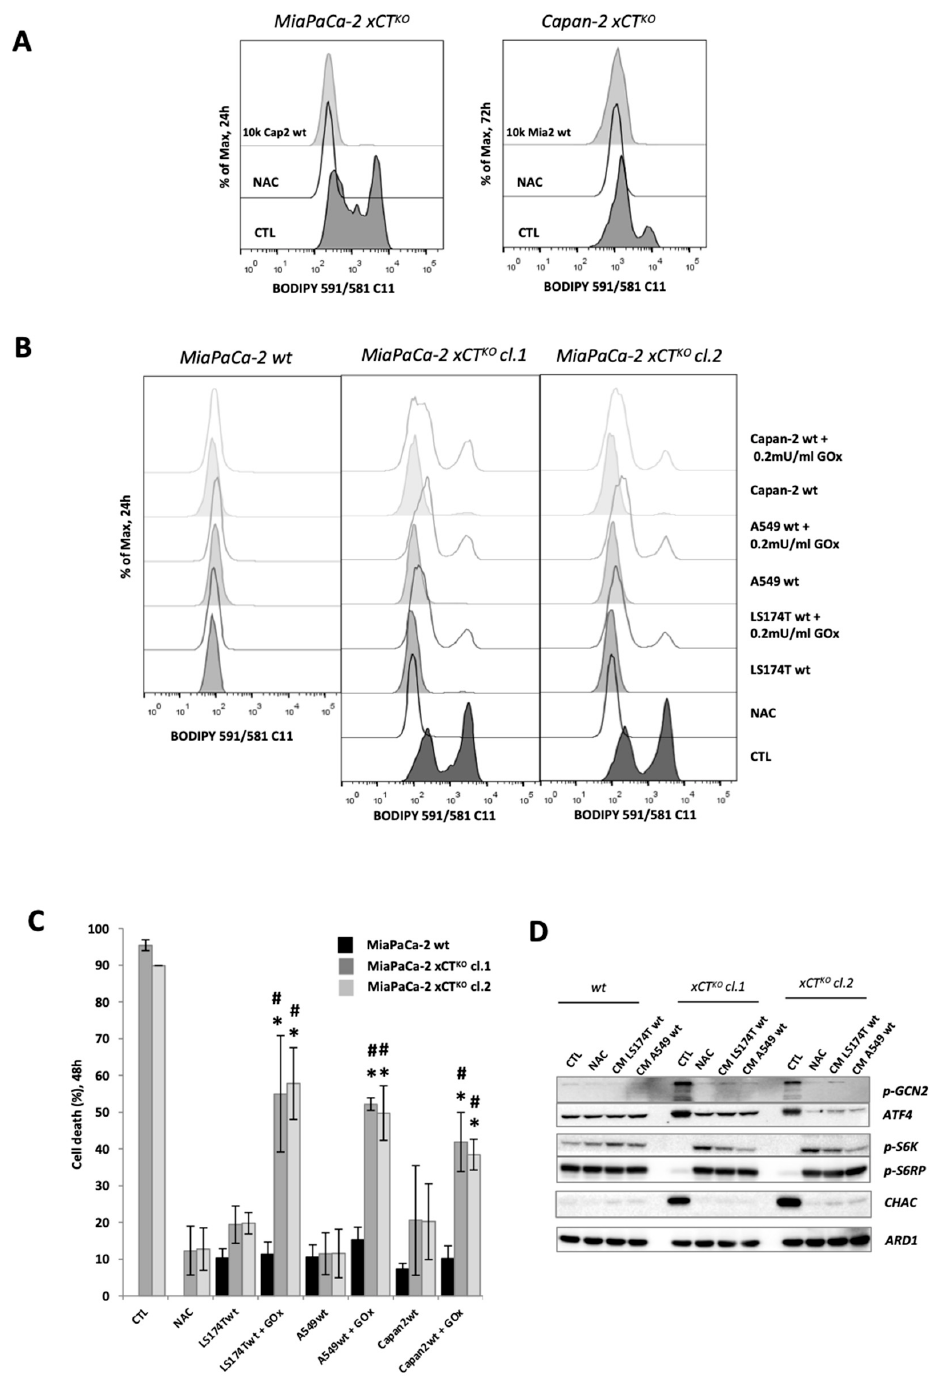
Figure 2. xCT-expressing cells export a redox-sensitive agent which prevents ferroptosis and restores amino acid imbalance in xCT KO cells. ( A ). Lipid hydroperoxide accumulation in xCT KO PDAC cells co-cultured with other PDAC wt cells or in media supplemented with an alternative cysteine-donor—N-acetylcysteine (NAC). ( B , C ). Phenotype of MiaPaCa-2 xCT KO cells co-cultured with different xCT-expressing cells (LS174T, A549 and Capan wt) in media +/ − the low dose of pro-oxidant, glucose oxidase (0.2 mU/mL GOx): B. BODIPY 591/581 C11 staining; ( C ). Cell death. ( D ). MiaPaCa-2 wt and xCT KO cells were cultivated for 24 h in DMEM +/ − 1 mM NAC, or in conditioned media (CM) of LS174T/A549 wt. Changes in phosphorylation status and protein abundance of members of the two major AA-sensing pathways GCN2 (p-GCN2/ATF4) and mTORC1 (p-S6K1 and p-RPS6) were analyzed by Western blot. All experiments have been performed in triplicate and the representative blots and histograms are shown. Bar graph shows mean ± SEM; n = 3; *, p < 0.05, comparison with WT control group; # , p < 0.05, comparison with the corresponding untreated